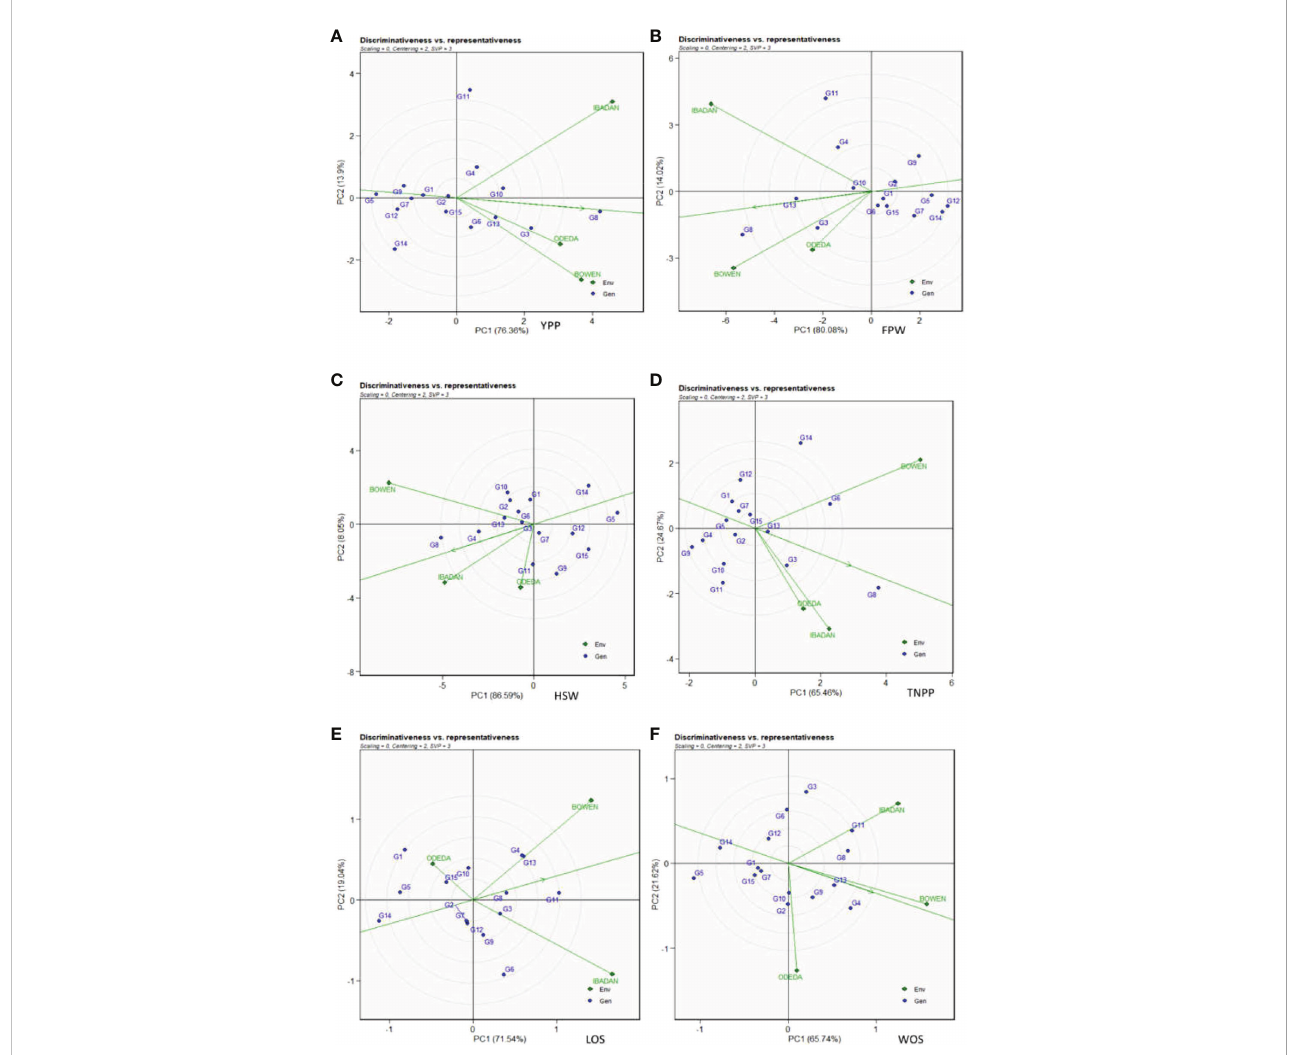
FIGURE 8 Discriminativeness and representativeness GGE biplot of 15 accessions under the effects of genotypes-by-environment interactions: (A) yield per plant (YPP), (B) fresh pod weight (FPW), (C) total no. of pods per plant (TNPP), (D) hundred seed weight (HSW), (E) length of seeds (LOS), and (F) width of seeds (WOS). The GGE biplot polygons were based on scaling = 0, centering = 2, and singular value partitioning (SVP) =